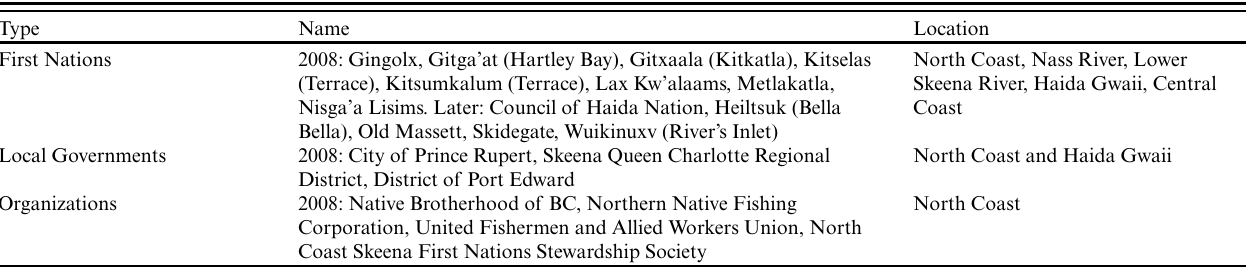
Table 2 . Sustainable Marine Fisheries and Communities Alliance’s initial membership (2008) and subsequent participants (2008-2012; Thorkelson 2012, City of Prince Rupert 2013). See Figure 1 for locations of names in parentheses.